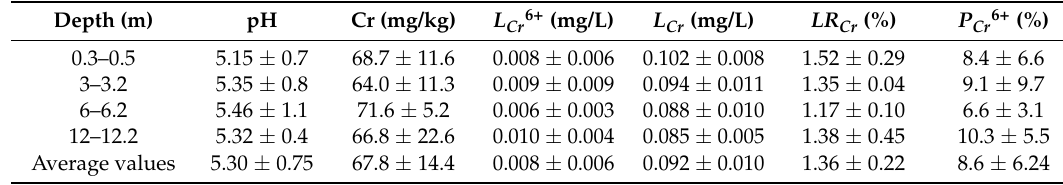
Figure A1. Soil layer structures of the soil profiles at 0–14 m in COPR Storage Area ( a ) and Prouduction Plant Area ( b ). Table A1. General characteristics of background